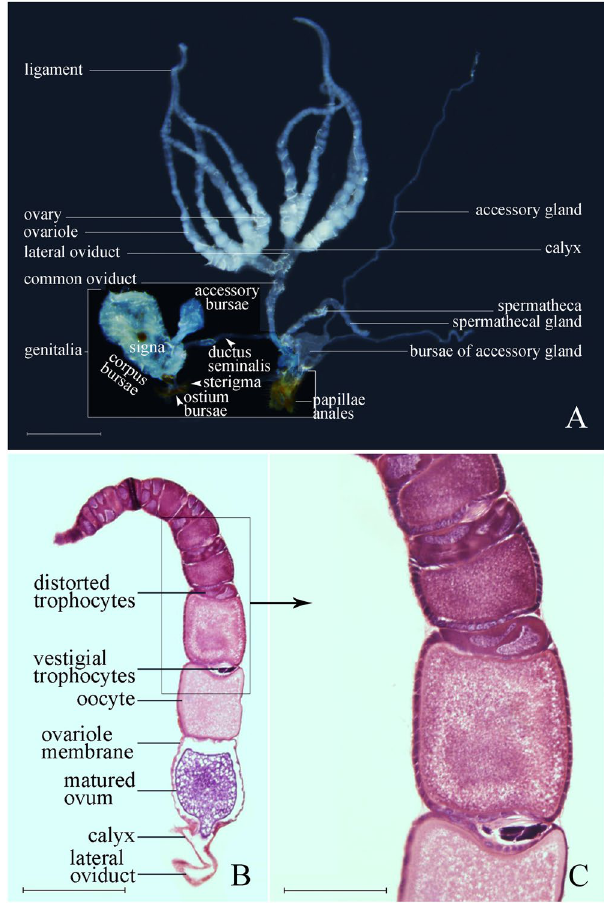
Figure 3. Female reproductive system of OFM. ( A ) Female reproductive system profile. Scale = 1.0 mm; ( B ) Ovarioles semithin longitudinal section. Scale = 0.50 mm; ( C ) Unmatured oocytes and trophocytes in ovarioles. Scale = 0.25